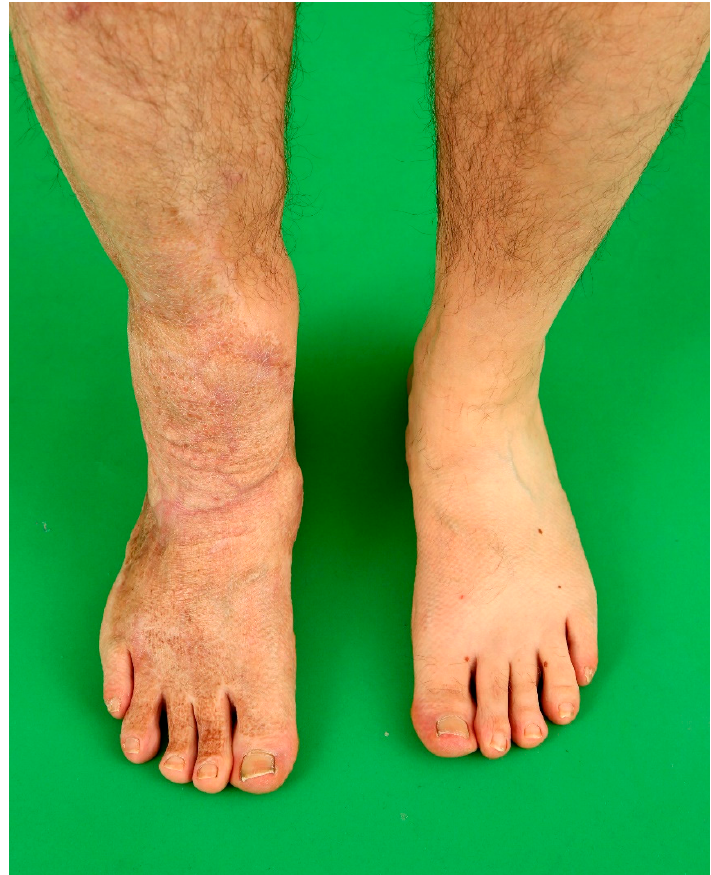
Figure 3. Postoperative outcome one year after free flap procedure. Both muscle flaps atrophied, providing a slim contour of the right ankle. Proper lymph drainage without secondary edema of the right foot is seen.